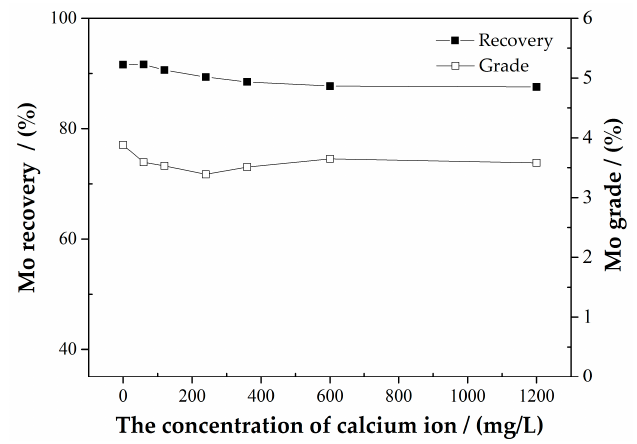
Figure 2. The influence of Ca 2+ concentration on AM flotation at pH 8.